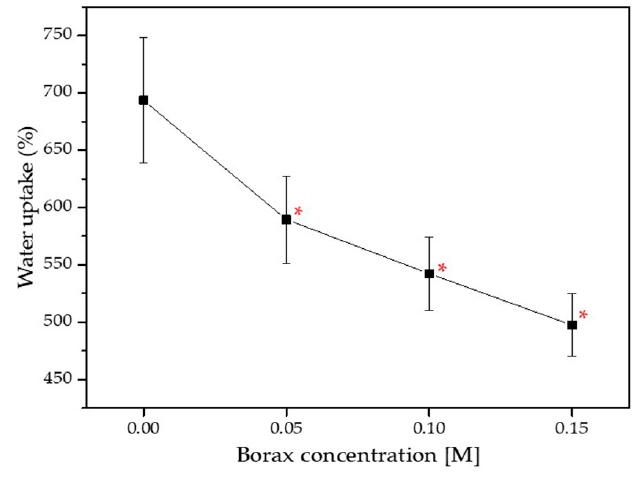
Figure 10. Water uptake of DN starch hydrogels prepared with various borax concentrations ( n = 3, * p < 0.05 compared with SN30 hydrogel (0.00 M of borax concentration).